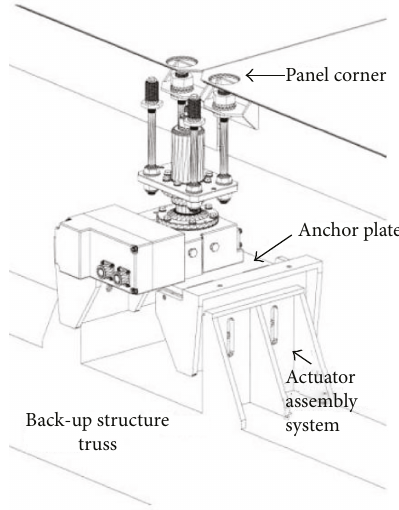
Figure 10: Actuator installation of the SRT [68].